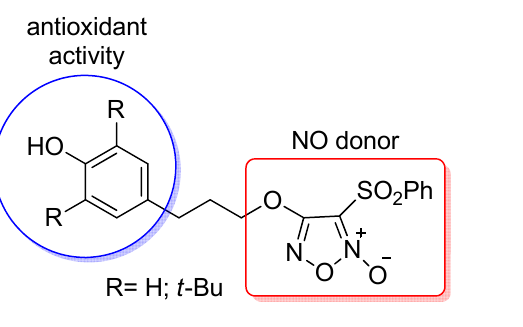
Figure 12. Hybrid anti-inflammatory antioxidant and NO